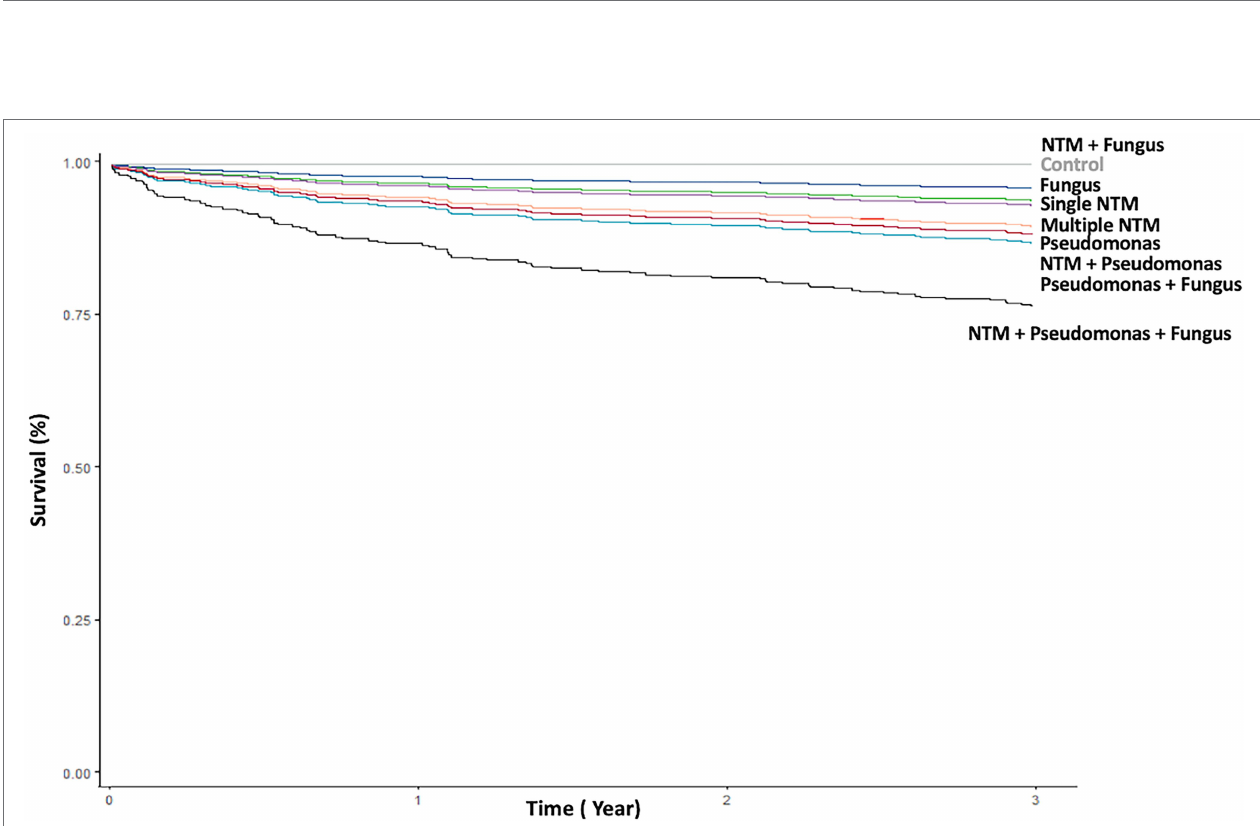
FIGURE 2 | Kaplan–Meier curve of ventilator use according to different pathogen isolates from sputum. NTM, nontuberculous mycobacteria.